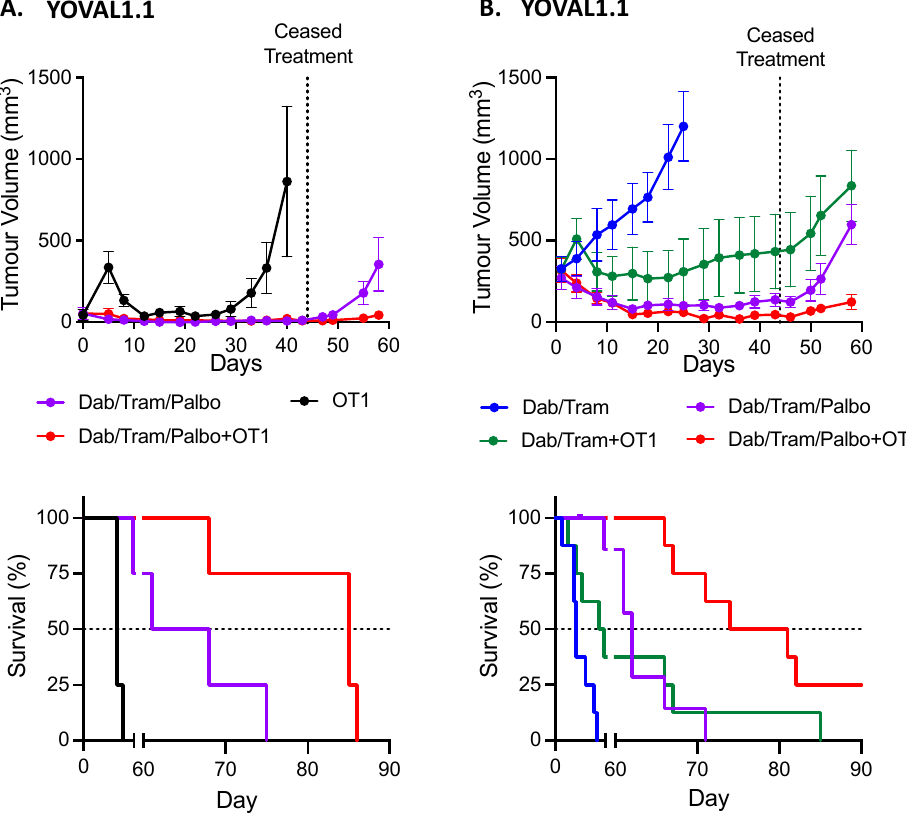
Figure 2. YOVAL1.1 tumor response to targeted and ACT. ( A ) In vivo YOVAL1.1 tumor volume growth and Kaplan–Meier overall survival curves of dabrafenib-trametinib-palbociclib (DTP ± OT-1 ACT with 4 mice per group (mean ± SEM). Gavages of DT ceased at day 44. Median overall survival (OS) for OT-1, DTP and DTP + OT-1 was 40, 64.5, and 85 days, respectively. OS hazard ratio (HR) for OT-1 versus DTP was 0.270, p = 0.006. OS HR of DTP versus DTP + OT-1 was 0.300, p = 0.03. ( B ) In vivo YOVAL1.1 tumor volume growth curve and Kaplan–Meier overall survival curves of dabrafenib-trametinib ± OT-1 ACT or dabrafenib-trametinib-palbociclib ± OT-1 ACT (mean ± SEM) with groups of 8 mice per each arm. Gavages of DT ceased at day 46. Median OS for DT, DTP, DT + OT-1 and DTP + OT-1 was 25, 62, 55, and 77.5 days, respectively. OS HR for DT versus DTP was 0.340, p = 0.02. OS HR for DTP versus DT + OT-1 was 1.154, p = 0.76. OS HR for DTP versus DTP + OT-1 was 0.250, p = 0.001. Hazard ratios determined with log-rank (Mantel- Cox).